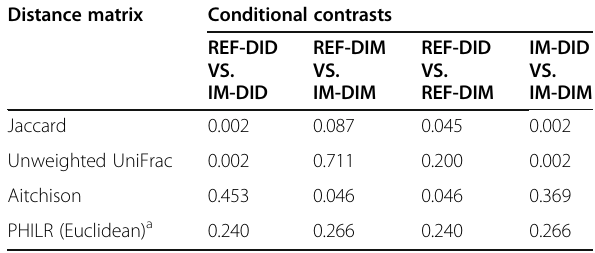
Table 3 Test of homogeneity of multivariate dispersions among groups Distance matrix Conditional contrasts